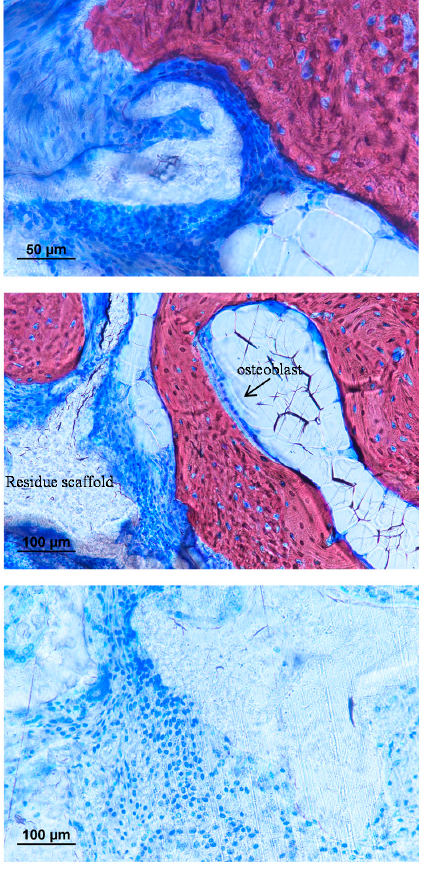
Figure 17. Histological staining in different locations of the critical-sized defect implanted with polyurethane composite filler (Alizarin red, counter stain with Toluidine blue). Osteoblast can be found next to the newly formed bones inside the porous filler.